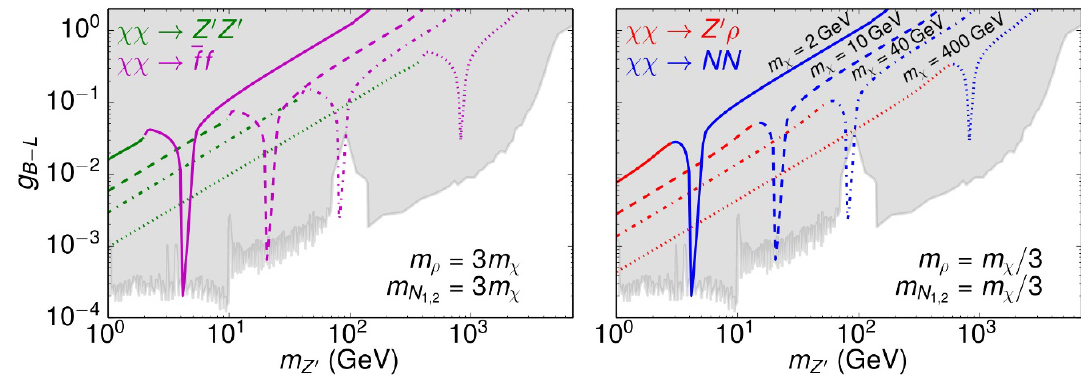
Figure 2 . Coupling as a function of Z 0 mass producing (cid:10) (cid:31) = 0 : 12 for various choices of the dark matter mass. The shaded region identi(cid:12)es couplings that are excluded from Z 0 searches at colliders (see (cid:12)gure 1). The colors depict the dominant annihilation channel for dark matter velocities v = 10 (cid:0) 3 , as is relevant for indirect searches. Left: masses are chosen such that both sterile neutrinos and the CP-even scalar are kinematically inaccessible (i.e. m N = m (cid:26) = 3 m (cid:31) ). Right: masses are chosen such that both sterile neutrinos and the CP-even scalar are kinematically accessible, and light with respect to the dark matter (i.e. m N = m (cid:26) = m (cid:31) = 3). The lines in the left panel correspond to the same dark matter masses as in the right